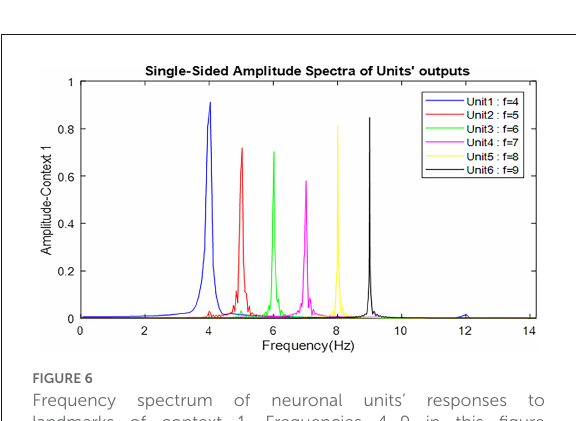
FIGURE6 Frequency spectrum of neuronal units’ responses to landmarks of context 1. Frequencies 4–9 in this figure are equivalent to main landmarks 1–6 in Figure 3 .